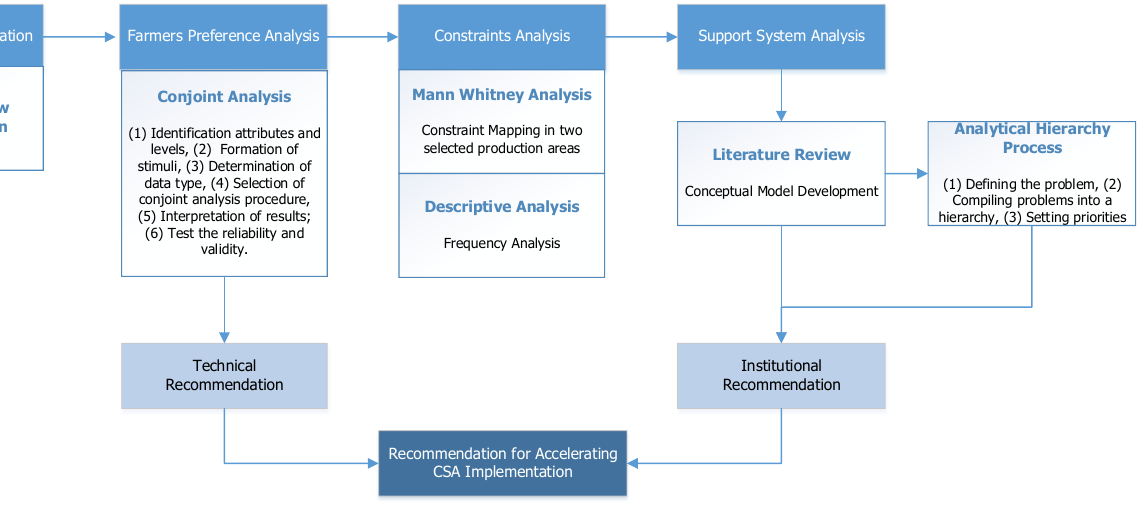
Figure 2. Research stages and data analysis method.